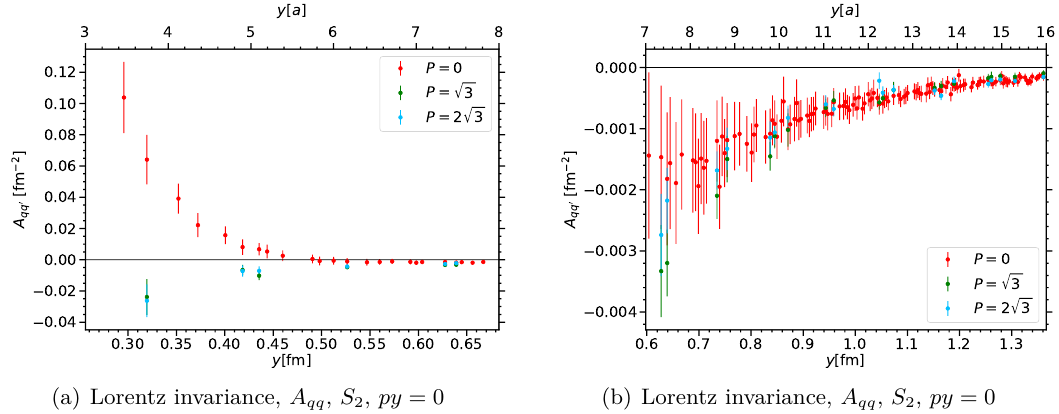
Figure 10 . The same as figure 9 for the S 2 contribution to A qq . This is shown for small distances (a), where breaking of Lorentz invariance is observed, and for large y